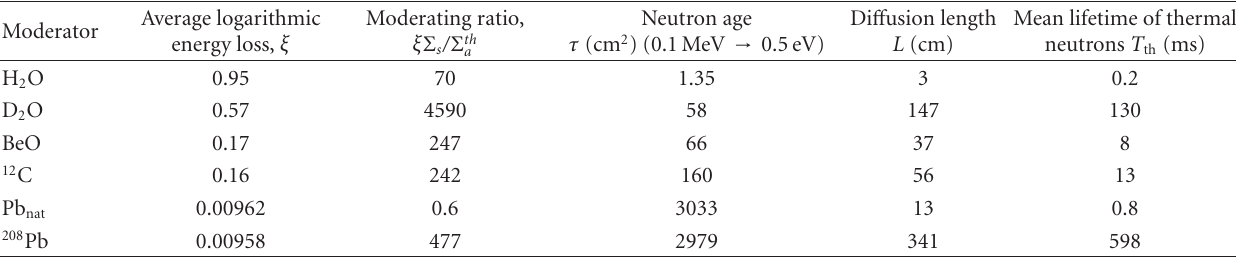
Table 2: Properties of neutron moderators at 20 ◦